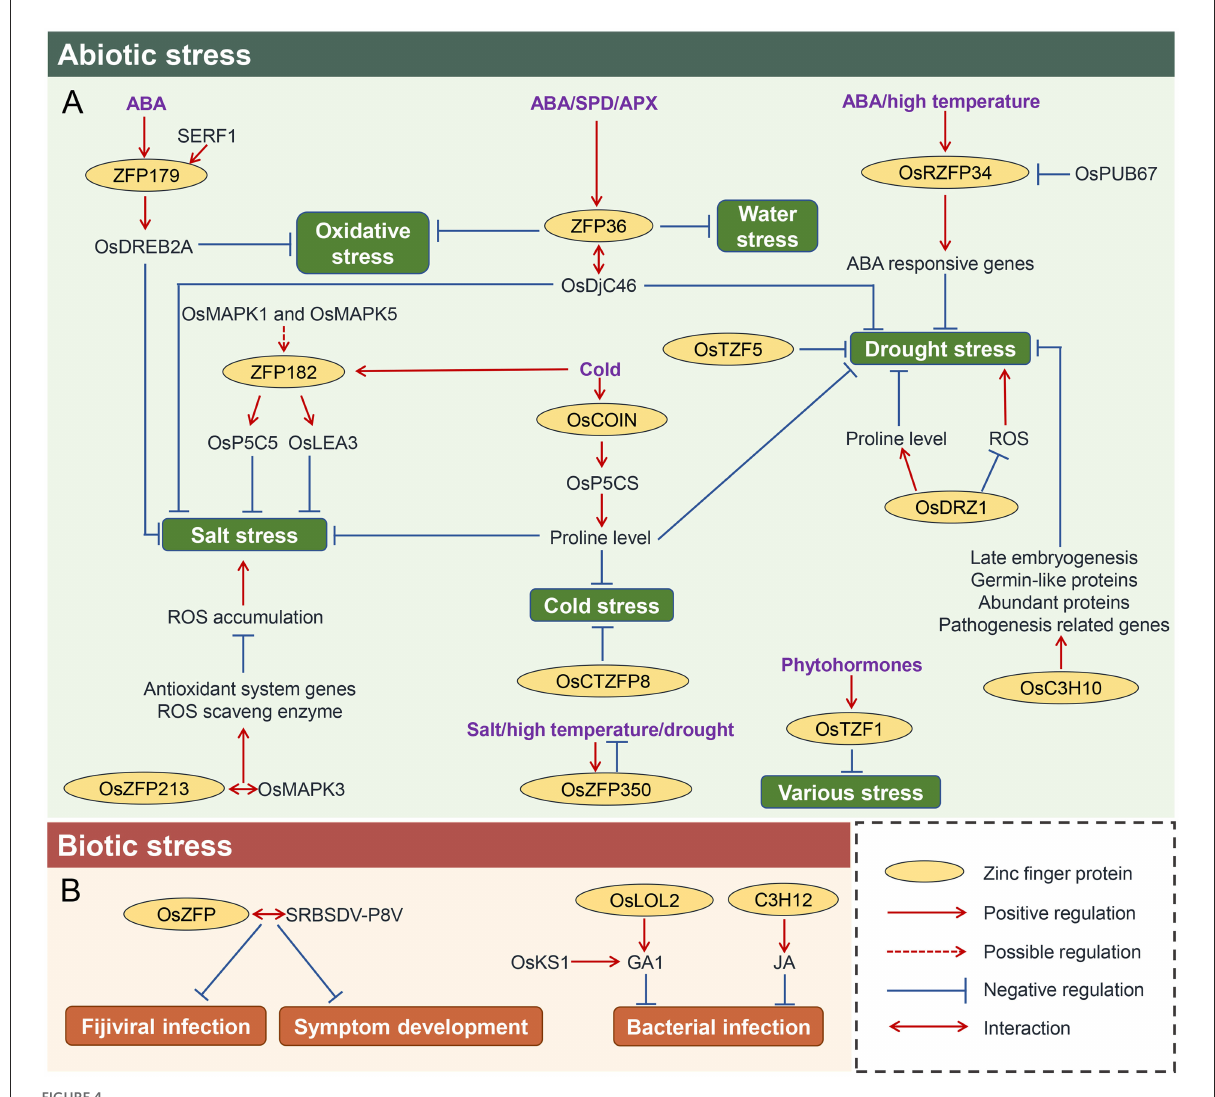
FIGURE4 Regulations of various stresses response by zinc finger proteins in rice. The regulatory network of zinc finger protein in response to abiotic stress (A) and biotic stress (B) . Positive and negative regulations of various stresses response mediated by different zinc finger proteins are indicated by solid lines, and the proposed regulation of zinc finger proteins on downstream targets is indicated by the dashed line. The proteins with cycle are the zinc finger proteins. Double arrow represents that the two proteins interact with each other. ABA, abscisic acid; SPD, spermidine; APX, ascorbate peroxidase; JA, jasmonic acid; GA, gibberellins; SERF1, salt-responsive ERF1; OsDREB2A, dehydration responsive element binding protein; OsDjC46, heat shock protein; OsP5CS, pyrroline-5-carboxylate synthetase; OsLEA3, Late embryogenesis abundant protein gene; OsPUB67, U-box E3 ubiquitin ligase; OsTZF5, CCCH-tandem zinc finger protein 5; OsDRZ1, drought-responsive zinc finger protein 1; OsCOIN, cold-inducible zinc finger gene; OsP5CS, pyrroline-5-carboxylate synthetase; SRBSDV-P8V, black-streaked dwarf virus protein P8; OsKS1, GA biosynthetic